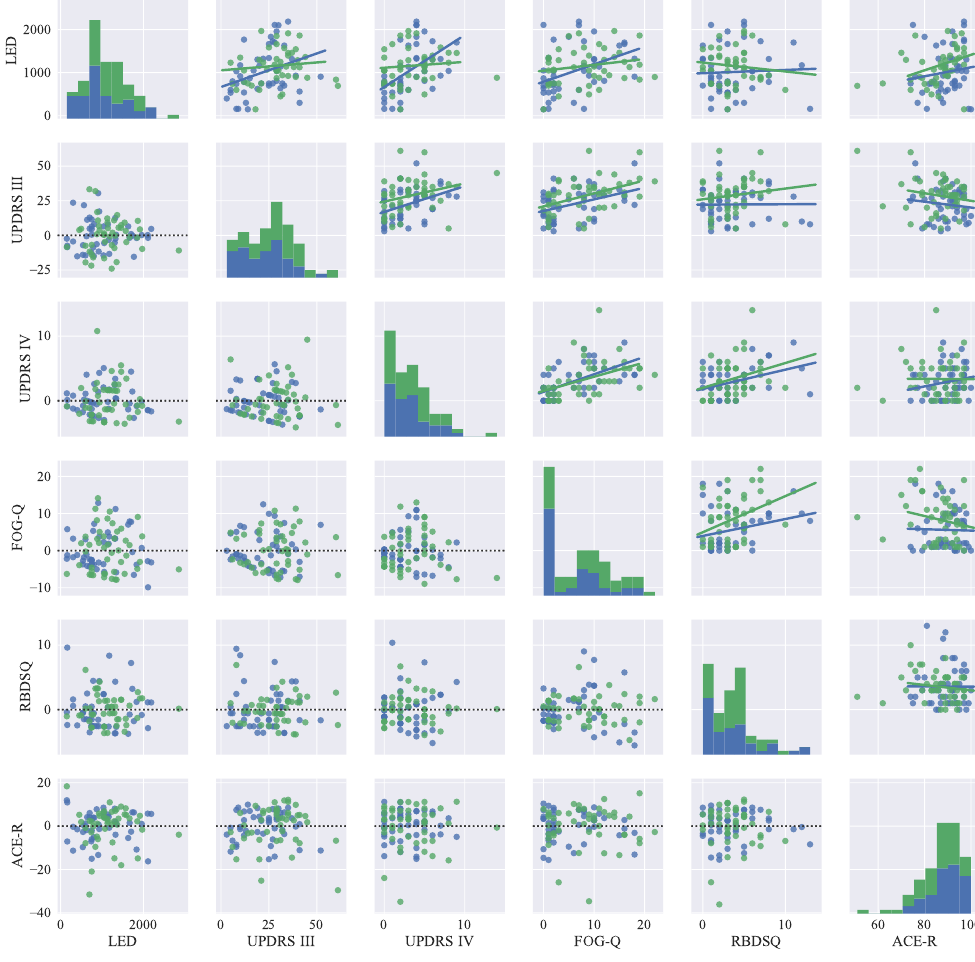
Figure 1. Descriptive statistical graphs of clinical characteristics of the PD patient dataset: on the main diagonal, histograms are visualized. Next, the upper triangular part of the graph-grid shows scatter plots with the fitted lines of linear regression models. Finally, the lower triangular part of the graph-grid is used to display residuals for the models shown in the upper grid. Color notation: the blue color represents data for session 1, and the green color represents data for session